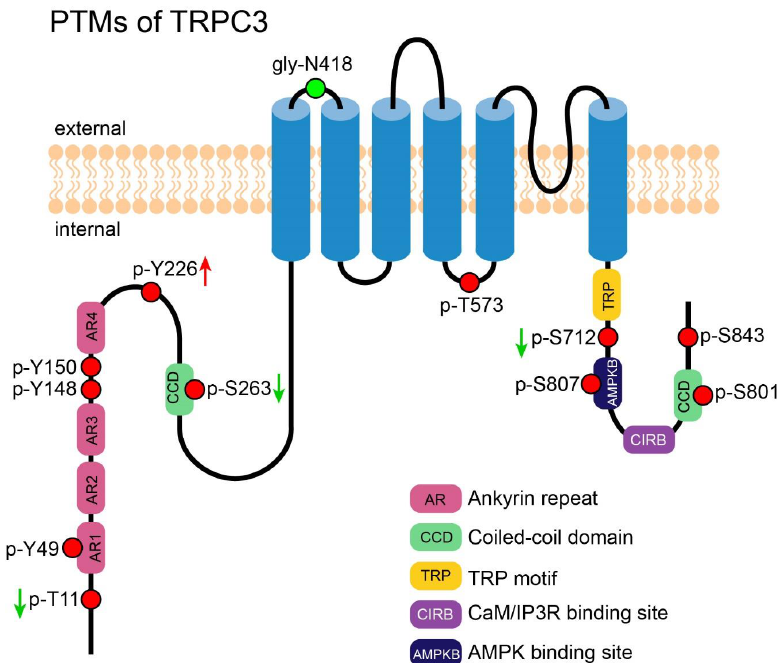
Figure 2. PTMs of TRPC3. A cartoon depicting TRPC3 with its important motifs and PTMs (those exact position had been reported). PTMs are presented in circles. Red circles represent the reported phosphorylation sites of TRPC3, which are labeled in the format of a “p-amino acid-position”. The green circle represents the reported N-glycosylation site; it is labeled in the format of a “gly-amino acid-position”. The green arrows near the labels denote the PTMs decreasing the channel’s activity. The red arrows near the labels denote the PTMs which increase the channel’s activity.